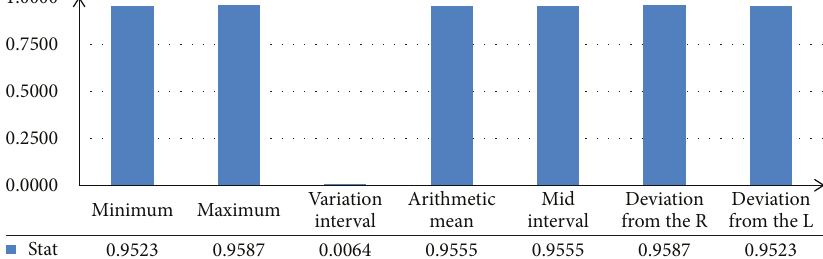
Figure 7: Operational availability statistics for period II.